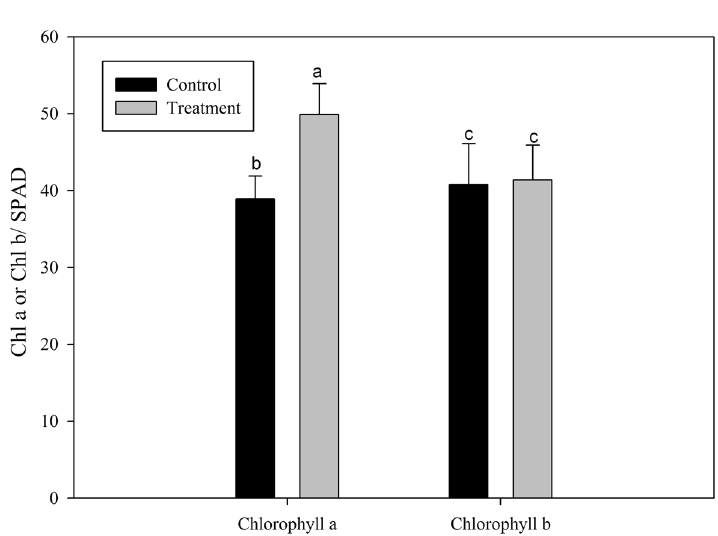
Figure 4. Effect of Chlorella extracts on the Chlorophyll content of pepper plants. Chlorophyll a and chlorophyll b were measured on 21st day after Chlorella extracts treatment. Control: no Chlorella extracts treatment; Treatment: plants were treated with Chlorella extracts; SAS analysis at 5% is shown in lowercase letters to indicate significant differences. Vertical bars in the figures represent were presented as mean ± SD, all experiments were carried out in